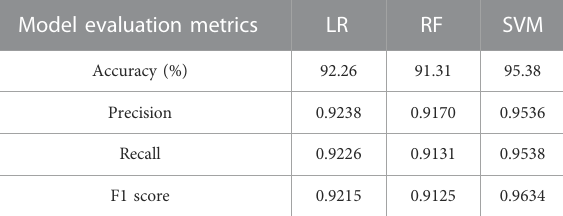
TABLE 1 Four evaluation metrics of different classi fi ers on test dataset. Model evaluation metrics